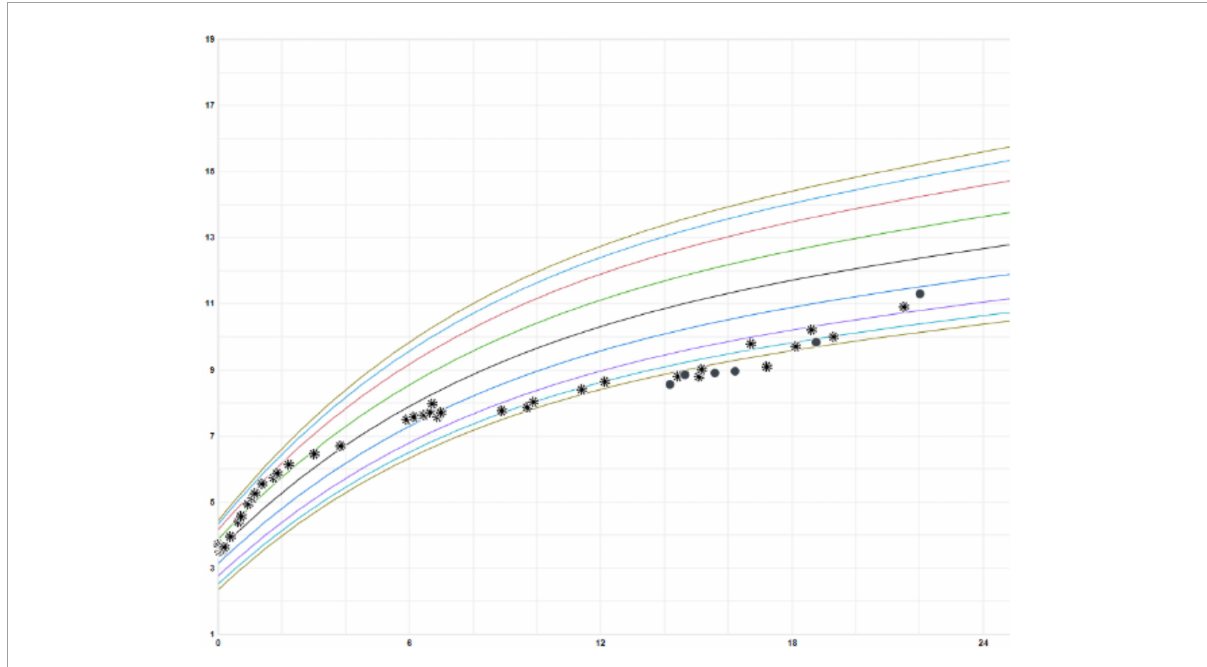
FIGURE3 Growth chart of patient’s weight (kilograms) over age